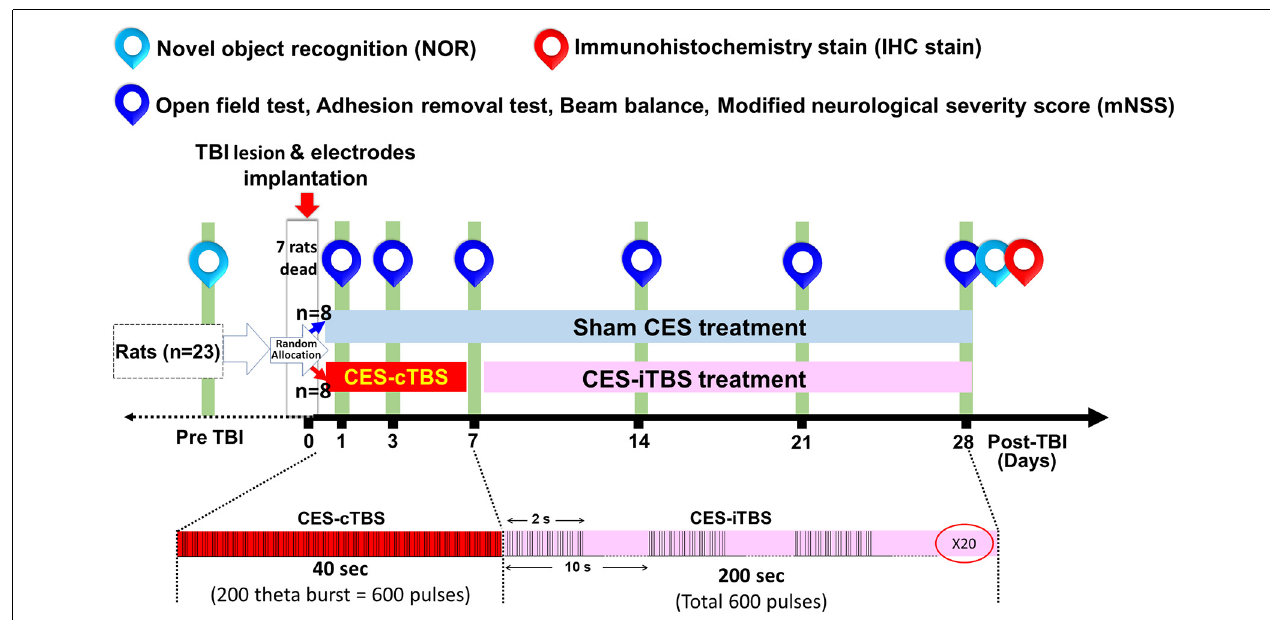
FIGURE 2 | Experimental design for the long-term treatment effects of CES. The TBI rats in the sham CES group remained in conditions identical to those of the CES group for the same period of time. In the treatment group, CES was performed in 20 sessions over 28 successive days, a session/day for 5 consecutive days per week. The inhibition and facilitation protocols were applied under the acute and subacute stages, respectively. The open field, adhesion removal, beam balance, and modified neurological severity score (mNSS) tests were performed every week to investigate long-term treatment effects. The novel object recognition (NOR) test was measured at baseline and 28 days post TBI lesion to identify the function of short-term recognition